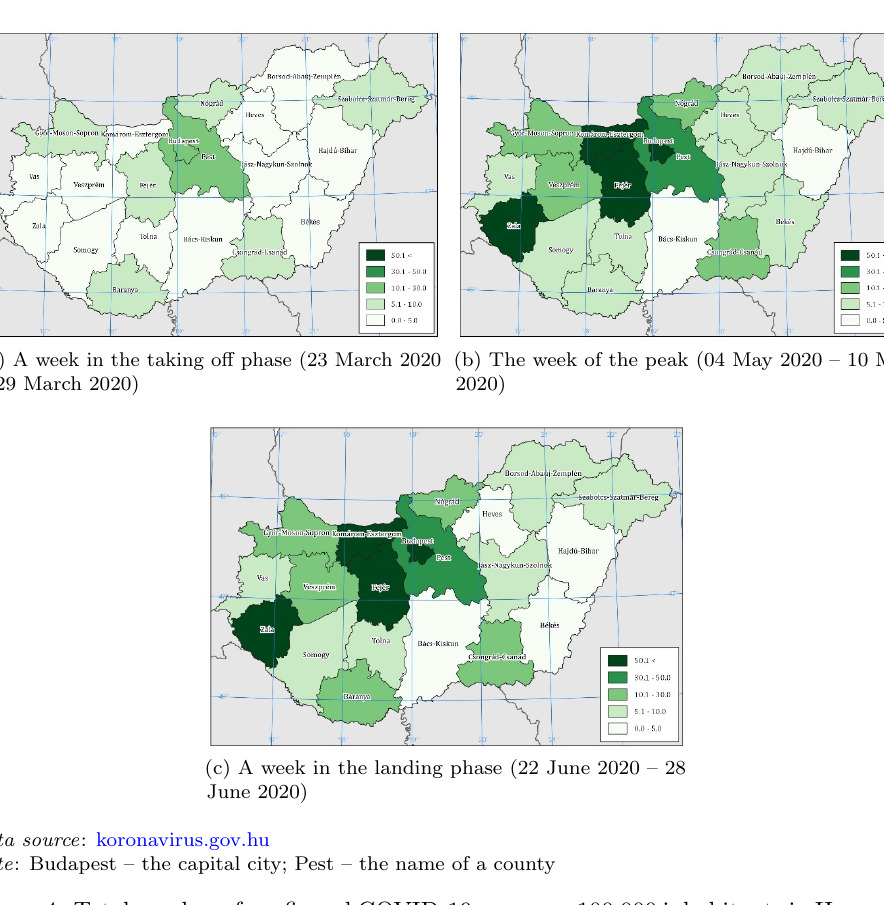
Figure 4: Total number of confirmed COVID-19 cases per 100,000 inhabitants in Hungarian counties (NUTS 3) during the different phases of the first wave, based on weeks most affected area from the beginning of the third wave. The spatial distribution of the confirmed cases showed a very high number in all counties during the entire